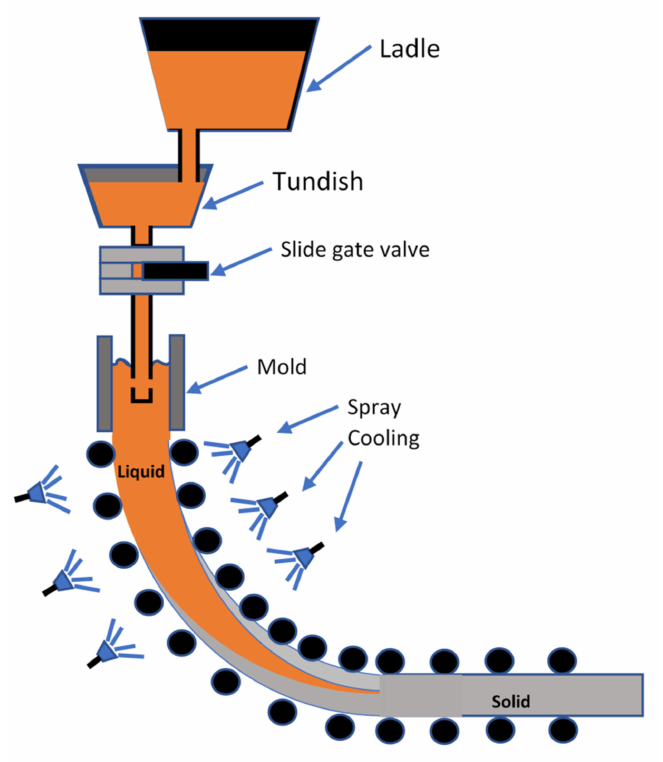
Figure 1. Continuous casting